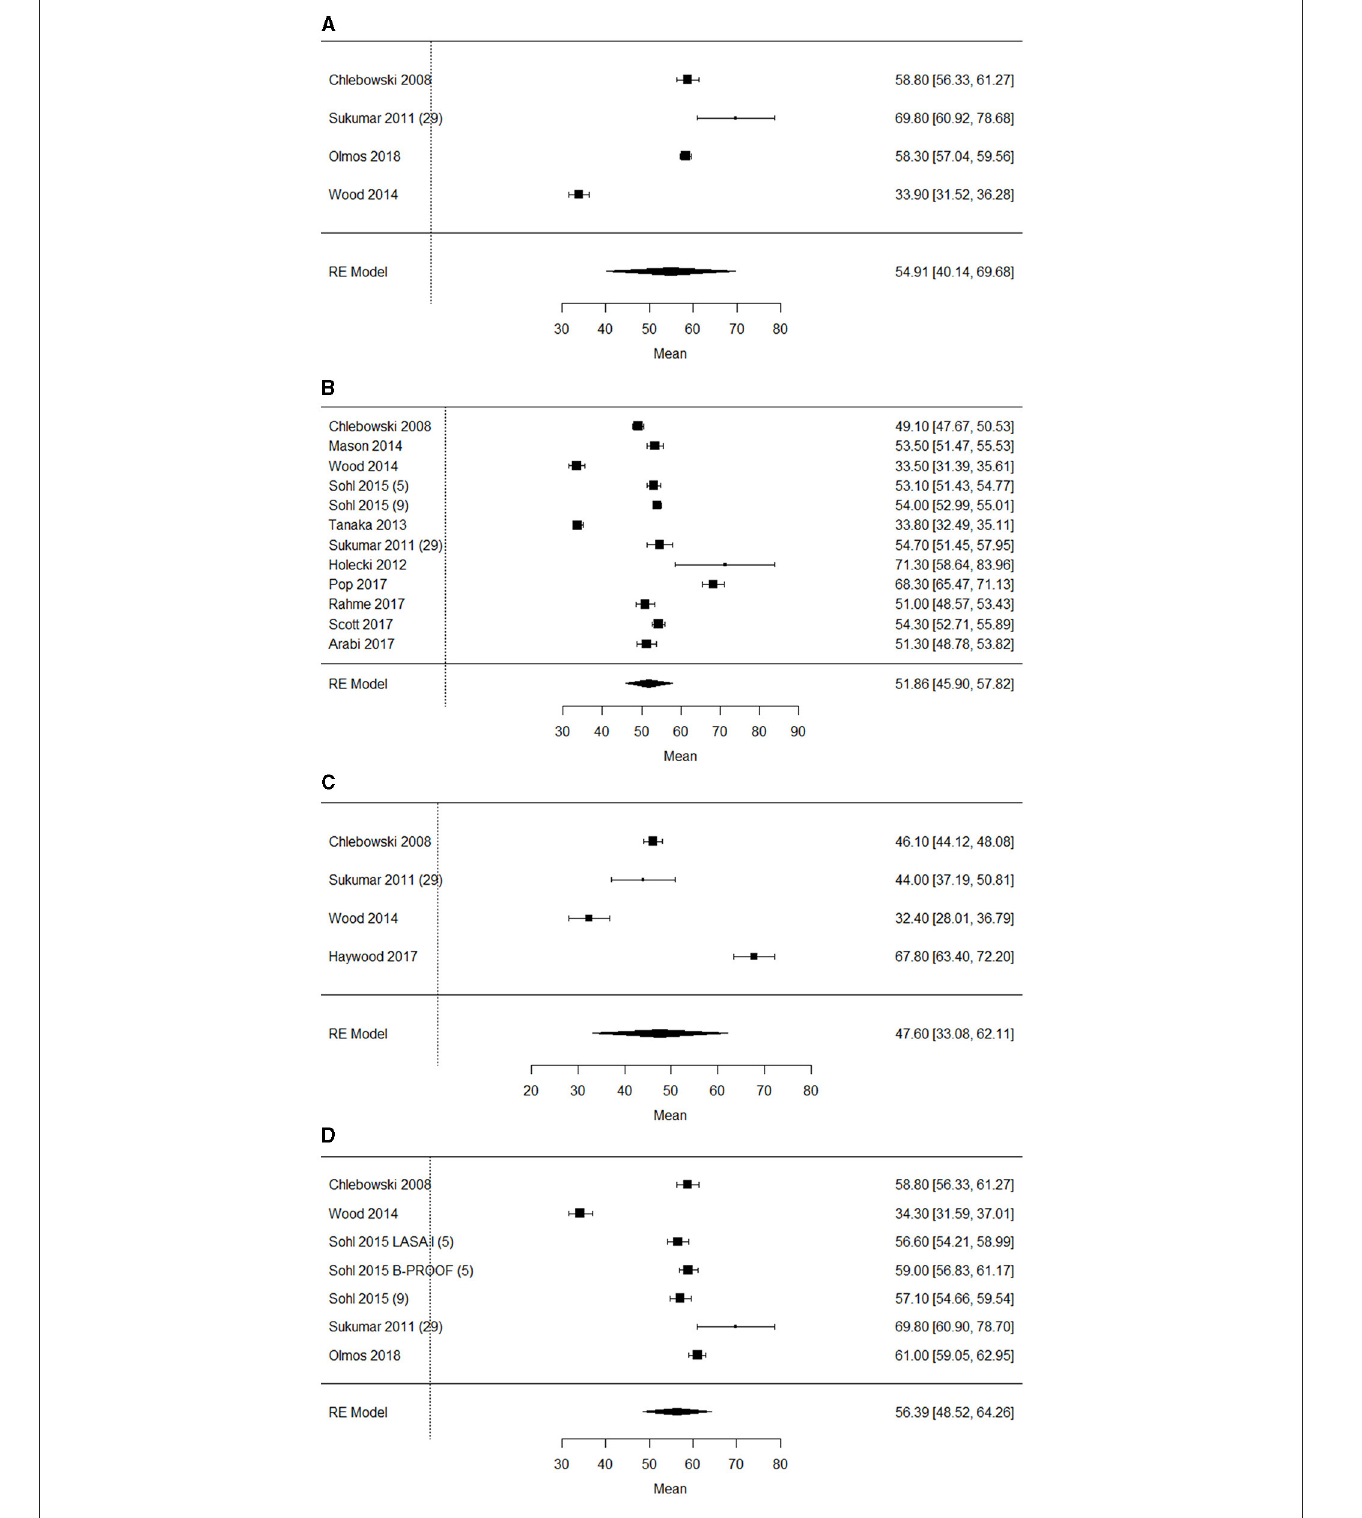
FIGURE 5 | (A) Forest plot of included studies on 25(OH)D concentrations (nmol/L) in older adults with overweight mean [95% confidence interval], RE, random effects. (B) Forest plot of included studies on 25(OH)D concentrations (nmol/L) in older adults with overweight/obesity mean [95% confidence interval], RE, random effects. (C) Forest plot of included studies on 25(OH)D concentrations (nmol/L) in older adults with obesity mean [95% confidence interval], RE, random effects. (D) Forest plot of included studies on 25(OH)D concentrations (nmol/L) in older adults with normal weight mean [95% confidence interval], RE, random effects.